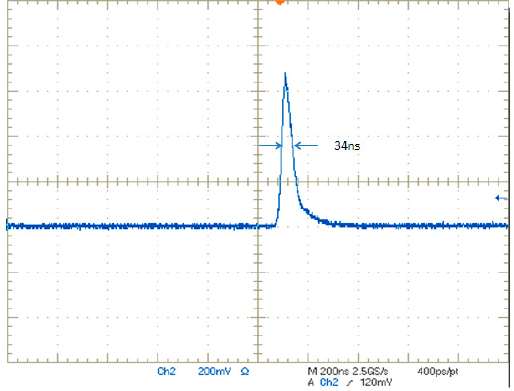
Figure 6. Typical pulse trace for the Raman